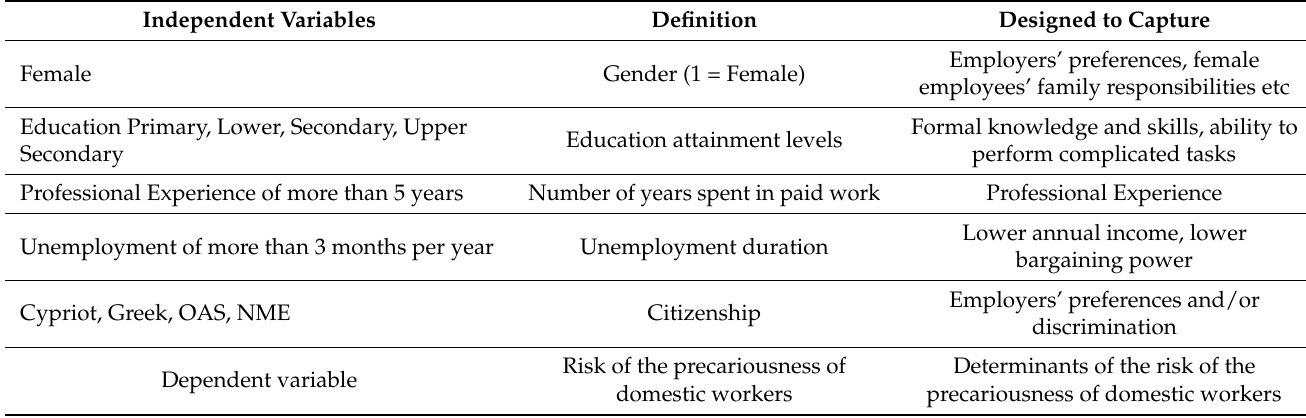
Table 4. Definition of the variables of the logistic regression for the determination of personal characteristics affecting the risk of